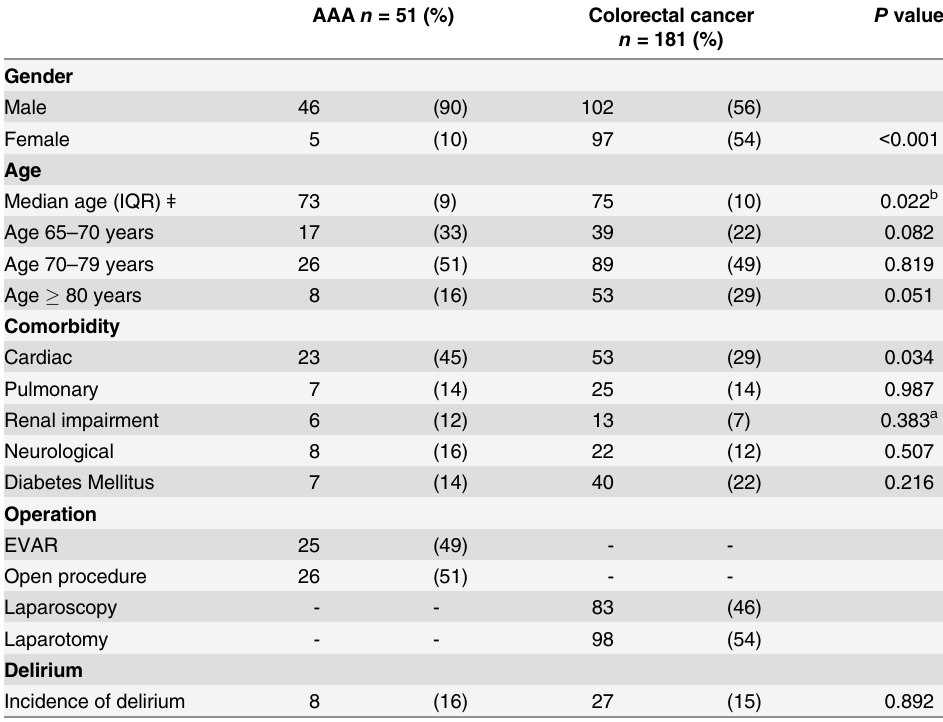
Table 1. Pre-operative characteristics in patients with AAA or colorectal cancer receiving elective surgery. P value AAA n = 51 (%) Colorectal cancer n = 181 (%)